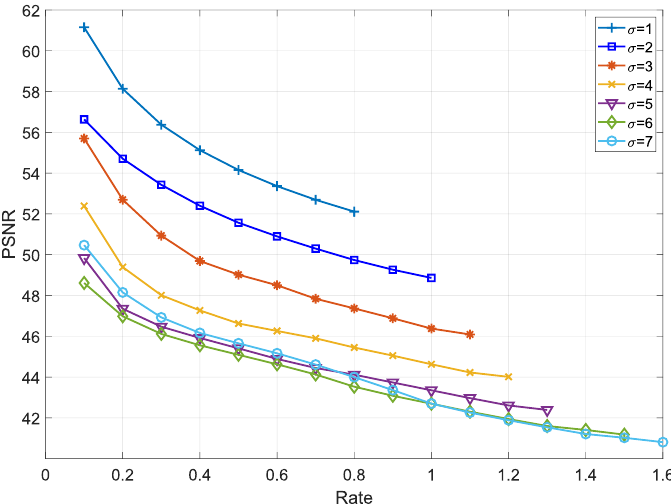
Figure 7. The relationship between BPP and PSNR according to control variable σ with depth map